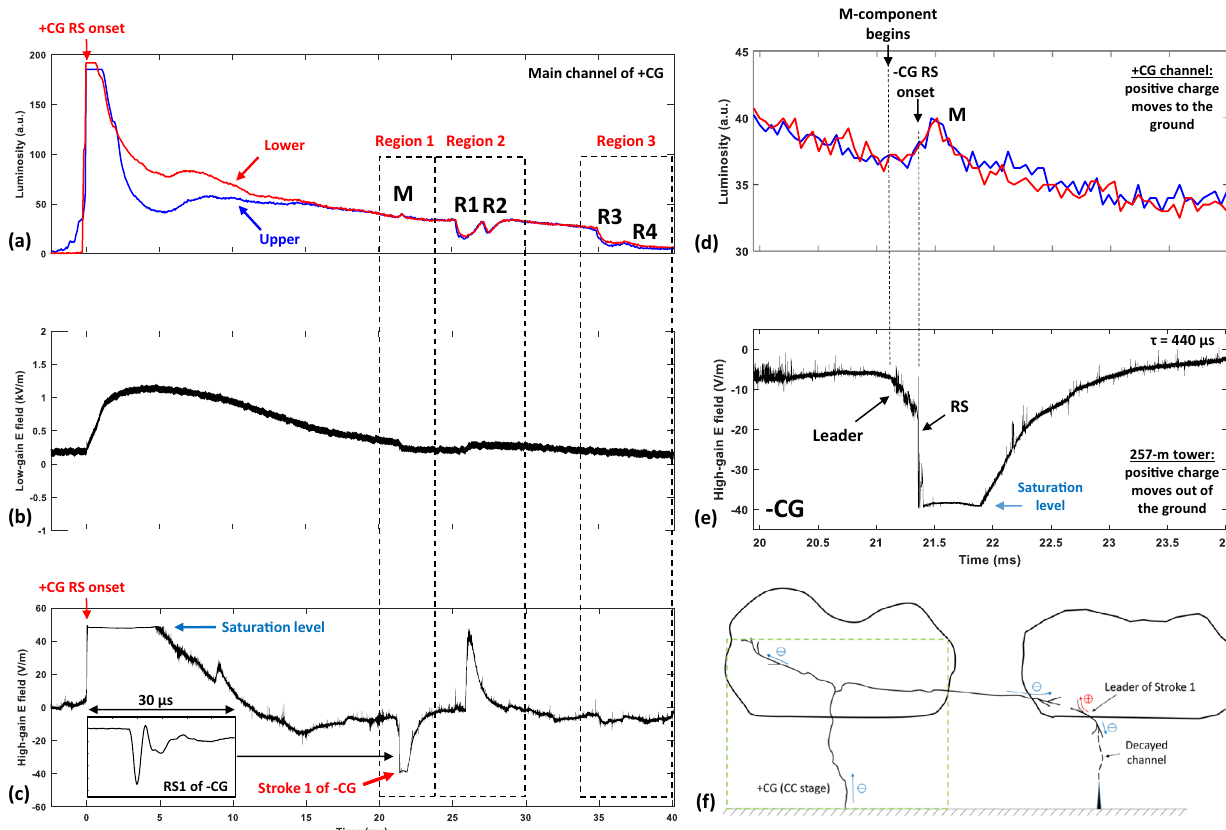
Fig. 3 Single-stroke positive Flash 1906. a Luminosity variations in the Upper (blue) and Lower (red) cross-sections of the + CG main channel, including M-component labeled M and four luminosity dips labeled R1 to R4. b , c Low-gain and high-gain electric fi eld waveforms, respectively, aligned (with ± 12.5- µ s uncertainty) with the luminosity variations shown in a . Inset in c shows the integrated dE/dt waveform for the RS of Stroke 1 of the -CG (see also Fig. S5 in Supplementary Note 4, where the same waveform along with the other six RS waveforms of the tower-terminated -CG are presented without saturation). Downward de fl ection of RS electric fi eld waveforms corresponds to the motion of negative charge to ground (or positive charge out of the ground). The – CG RS onset signi fi es the movement of positive charge from the ground to the cloud at the position of the tower, occurring at the same time as the positive charge moves to the ground in the form of M-component at the position of + CG channel. Region 1 (except for the middle panel) is shown on an expanded time scale in d and e , with f showing our hypothetical scenario leading to establishment of a transient in-cloud link between the + CG and the tower-terminated – CG. A more complete version of this scenario is found in Supplementary Note